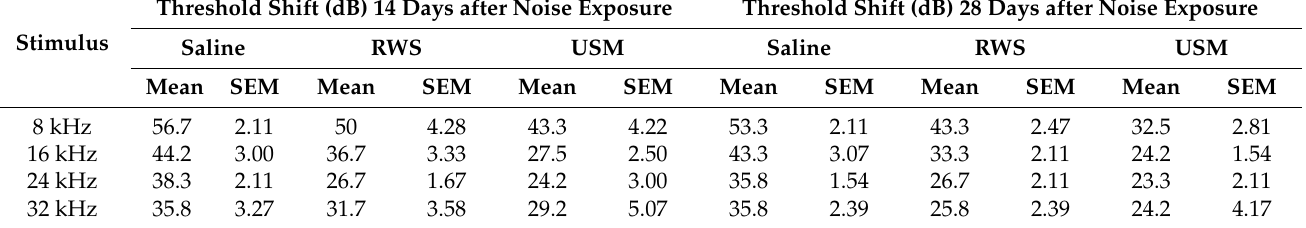
Table 1. Threshold shift of ABR in the saline, RWS (round window soaking) and USM (ultrasound microbubble) groups after noise exposure.